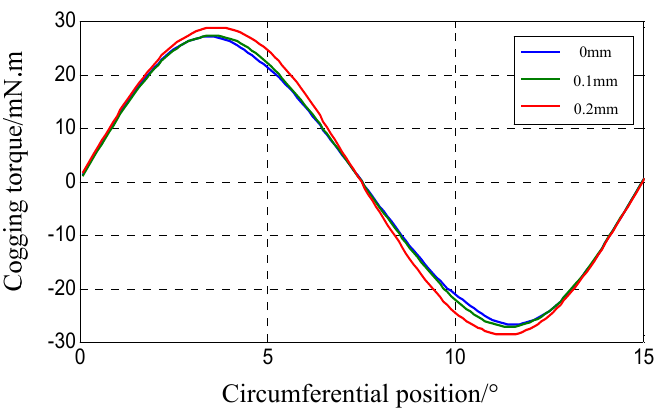
Figure 16. Comparison of cogging torque without skew in a variable period.